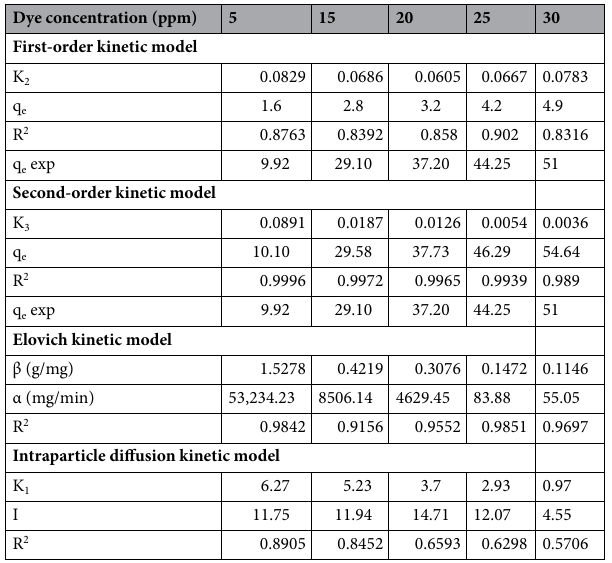
Table 3. Parameters of the kinetic models for MB dye adsorption onto 50 mg AC500/NZ at 25 °C and pH